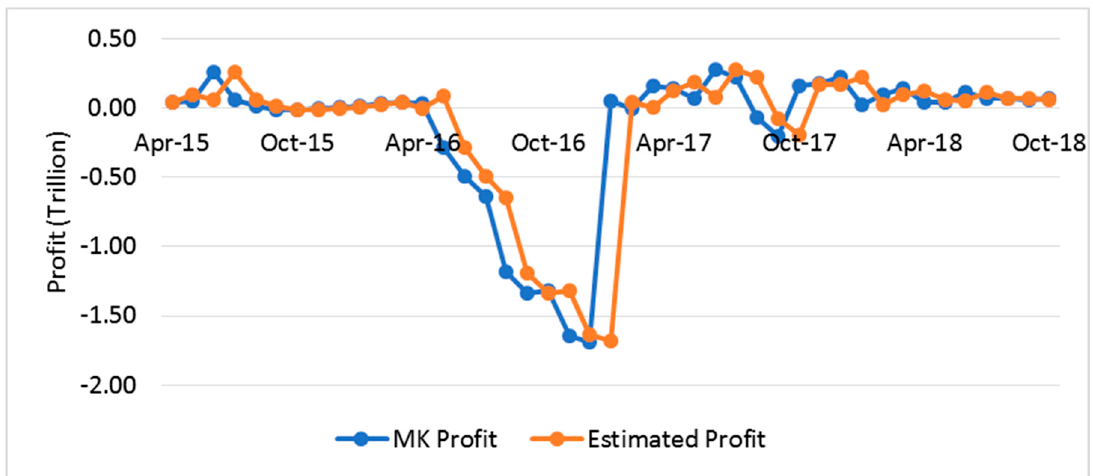
Figure 5. Monti-Klein (MK) profit and estimated profit of Bank A.